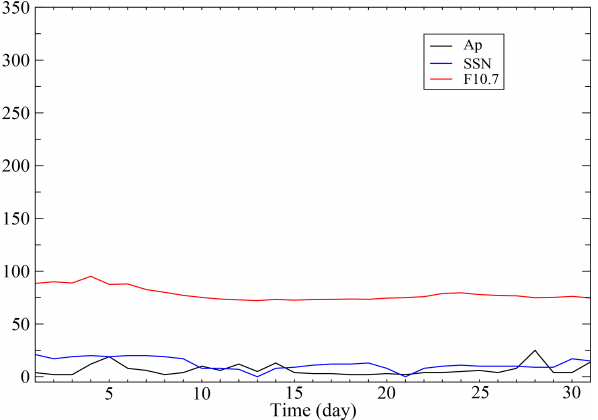
Figure 6. Daily values of Ap, international SSN and F10.7 for July